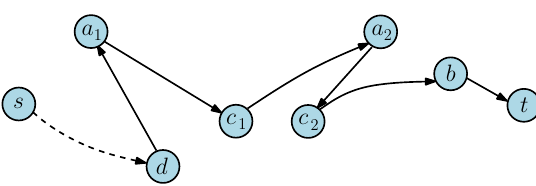
Figure 5 An optimal solution to the example from Fig. 3 exploiting